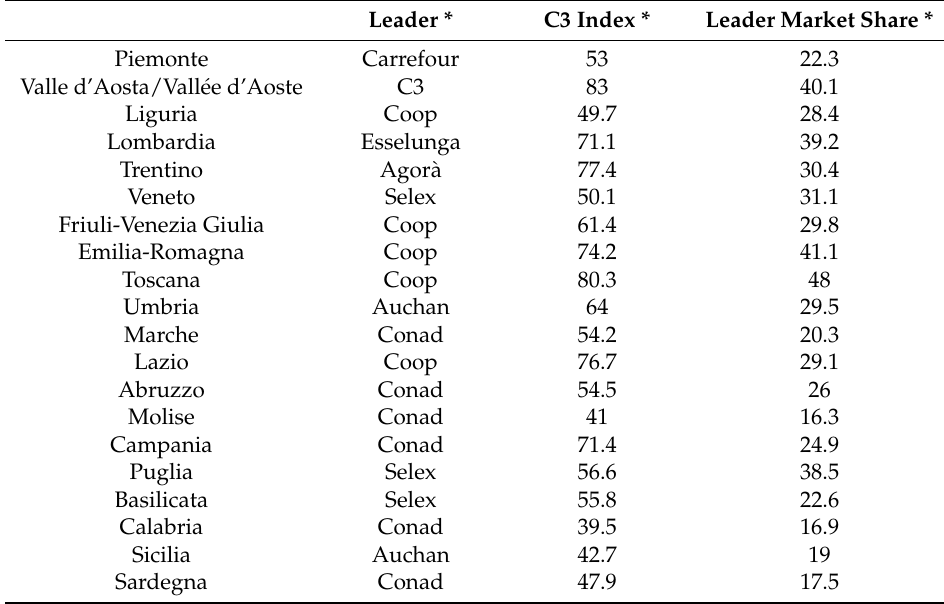
Table 1. Indicators of large retail by